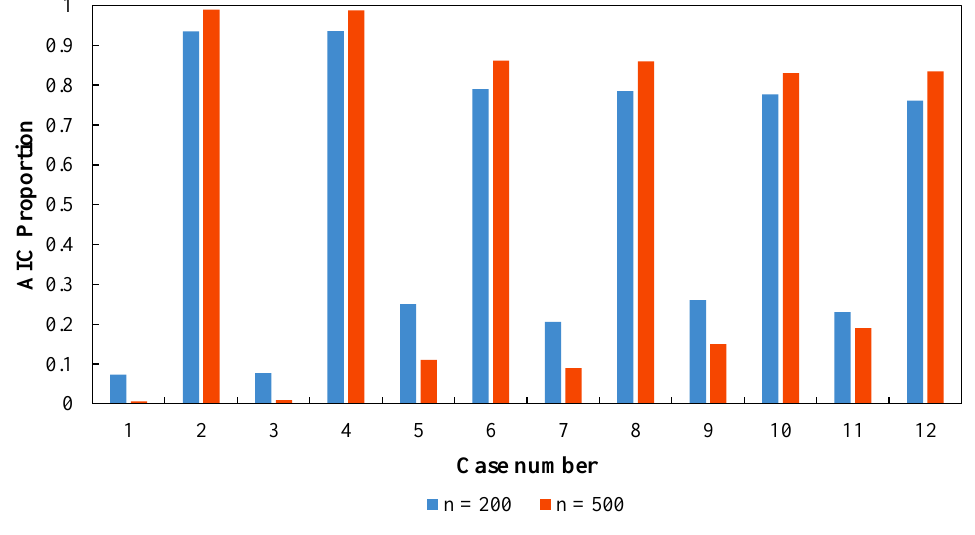
Figure 2. AIC proportion of the EME